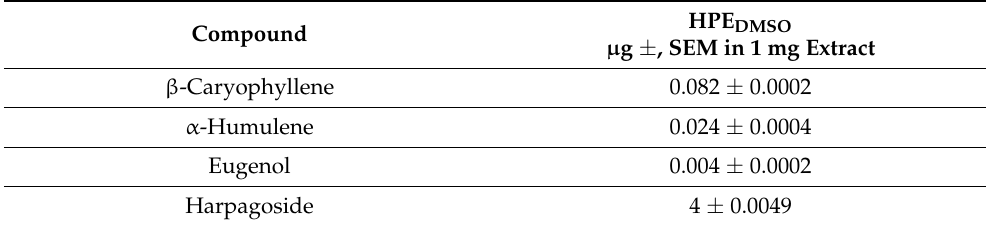
Table 1. Absolute concentration of major single volatile compounds and harpagoside, the main component of H. procumbens root extract. The concentrations were determined in 0.1 mg/mL HPE DMSO. Data are expressed as µ g ± SEM per mg of extract ( n = 3).